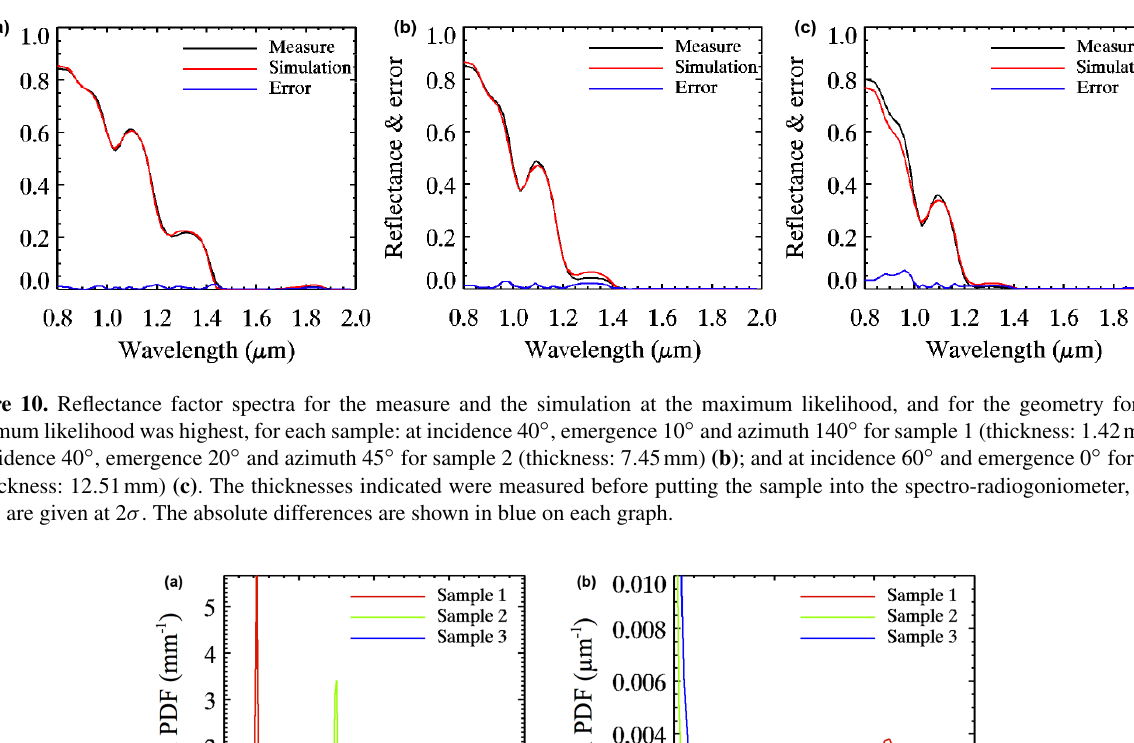
tends to increase with incidence and decrease with